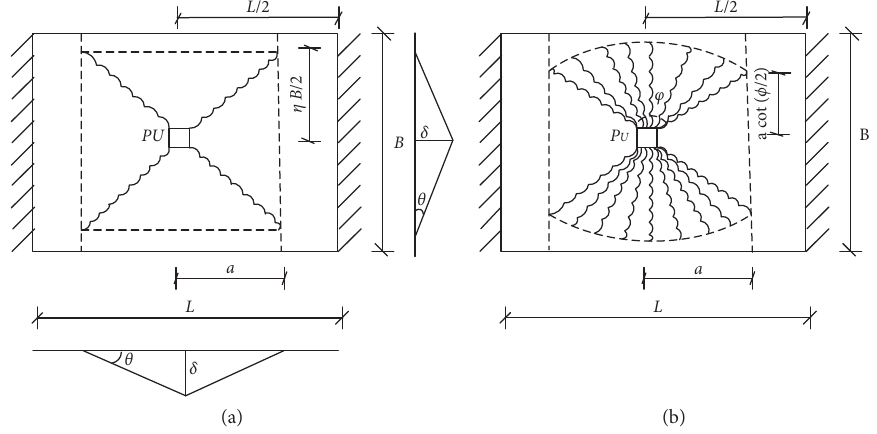
Figure 15: The theoretical analysis of failure patterns. (a) Failure pattern I (b) Failure pattern